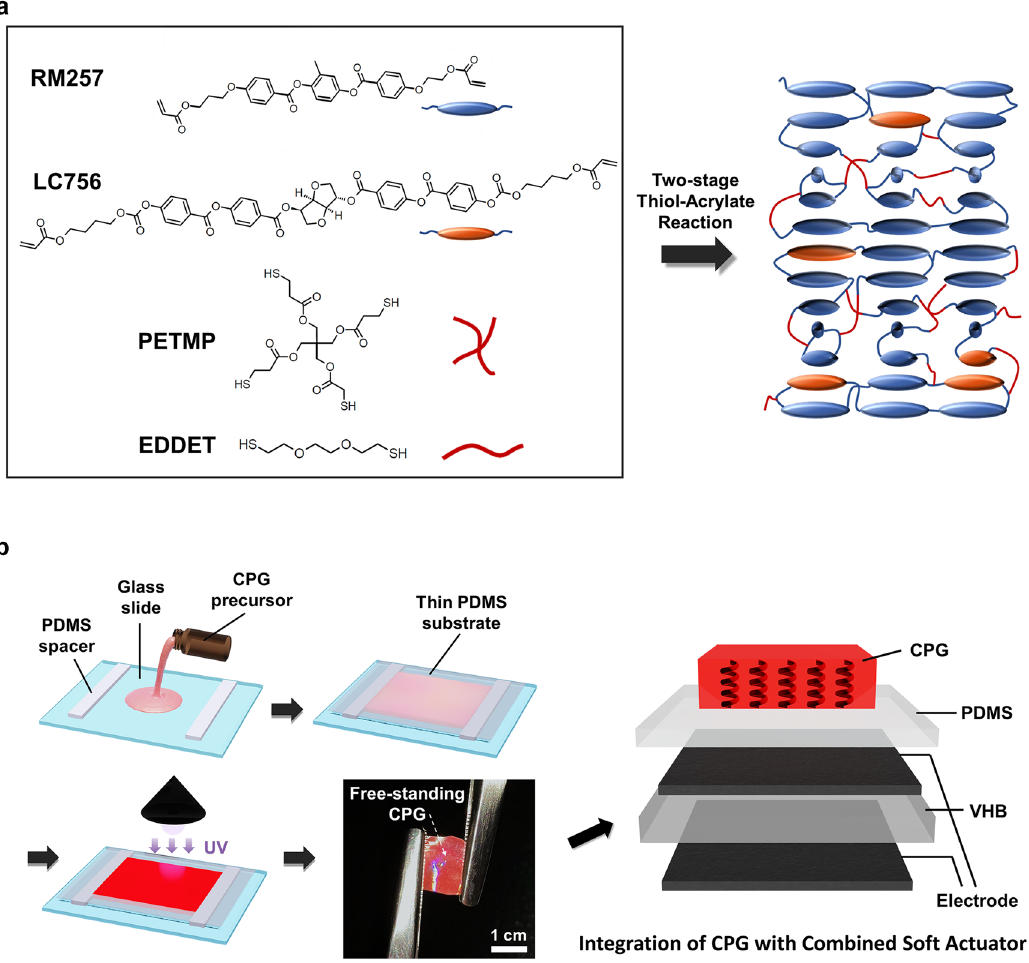
Figure2: Thepreparationofmechanicallyandelectricallystretchablechiralphotonicgelsamples:(a)descriptionofcurablechiralpremixture materials; (b) preparation of integrated chiral photonic gels with a combined soft